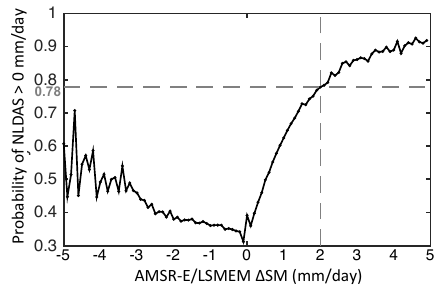
Figure 13. Probability that the added rainy days (3B42RT = 0mmday − 1 , 3B42RT ADJ > 0mmday − 1 ) are true rain events (NLDAS > 0mmday − 1 ) given corresponding AMSR- E/LSMEM (cid:49)